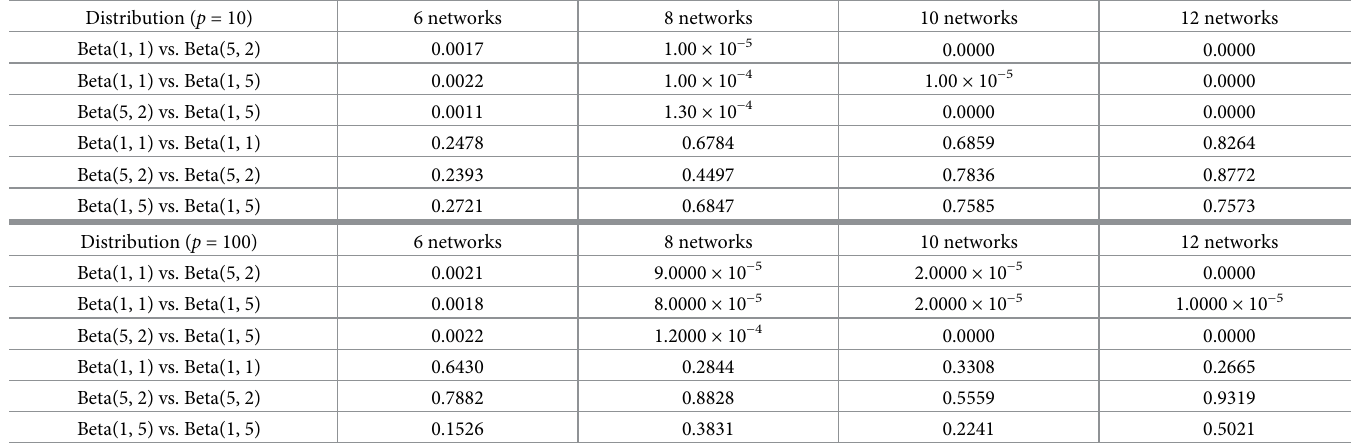
Table 1. The average p -values obtained using the ETL statistic for various pairs of distributions for small ( p = 10) and large ( p = 100) network settings. Here, the col- umns 6 networks, 8 networks, 10 networks, and 12 networks indicate the number of networks that we considered for both the groups. The p -values smaller than 0.01 indi- cate that our method can identify network differences at a 99% confidence